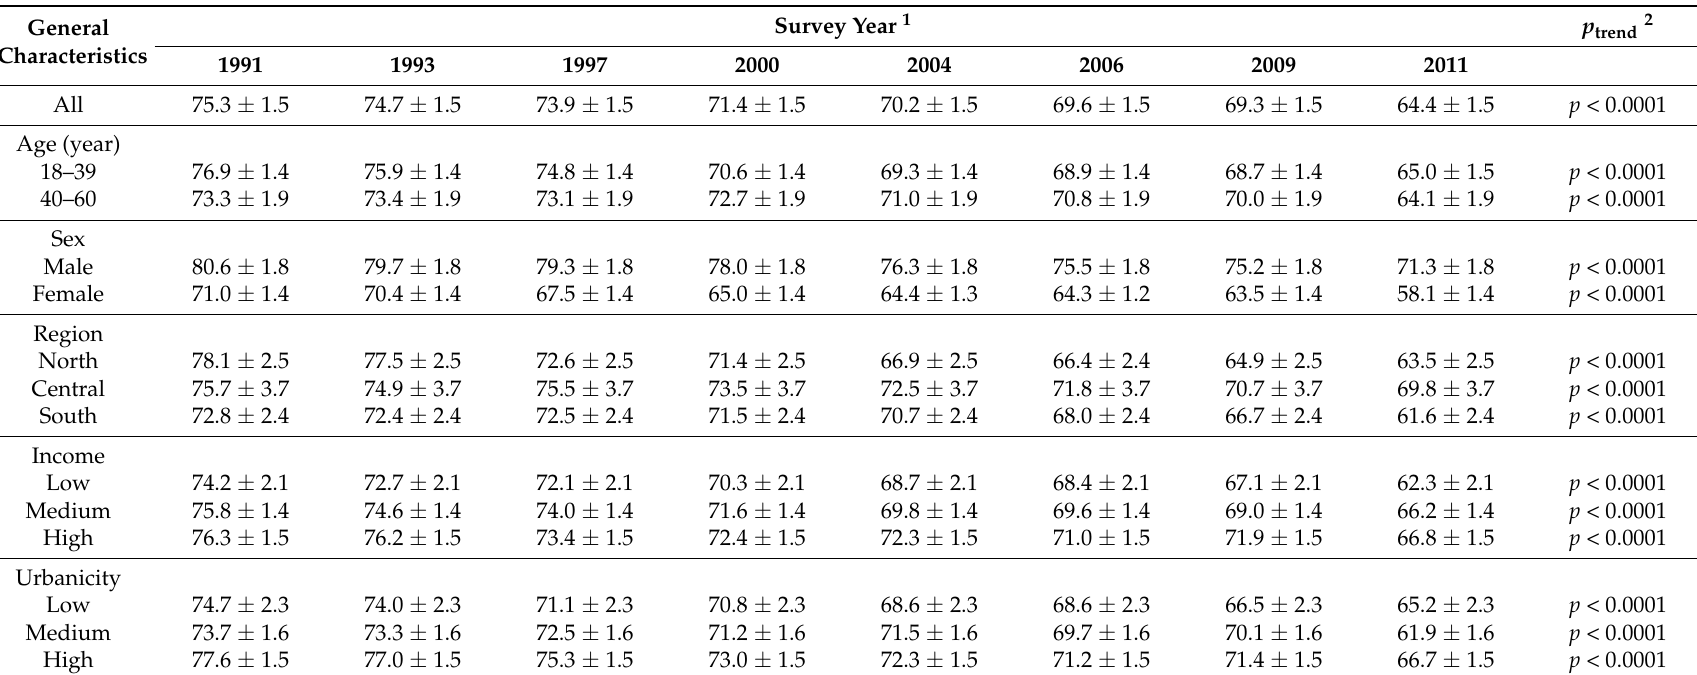
Table 6. Daily protein intake (g), by age, sex, geographical region, income, and urbanicity, in Chinese rural adults from 1991 to 2011.